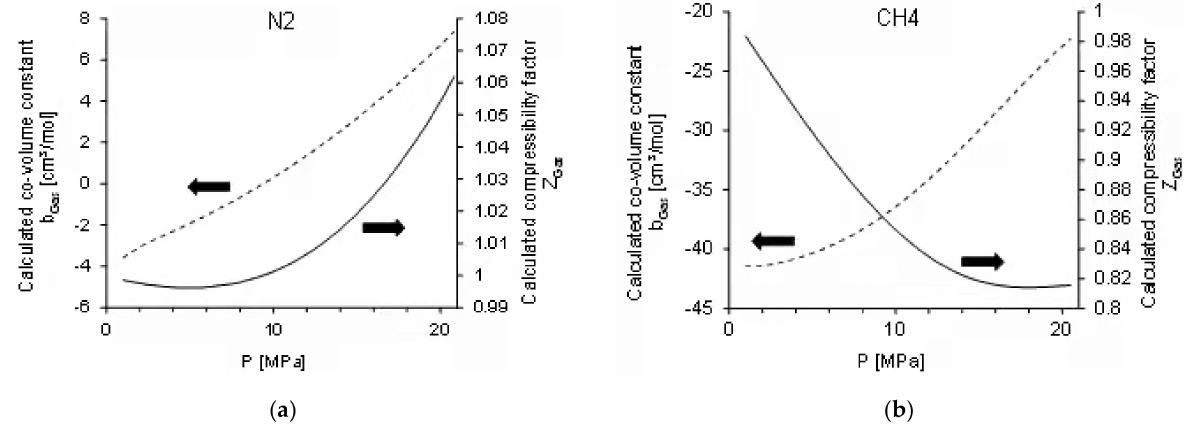
Figure 2. Calculated co-volume constants and compressibility factors according to Equation (6) of ( a ) N 2 , ( b ) CH 4 .